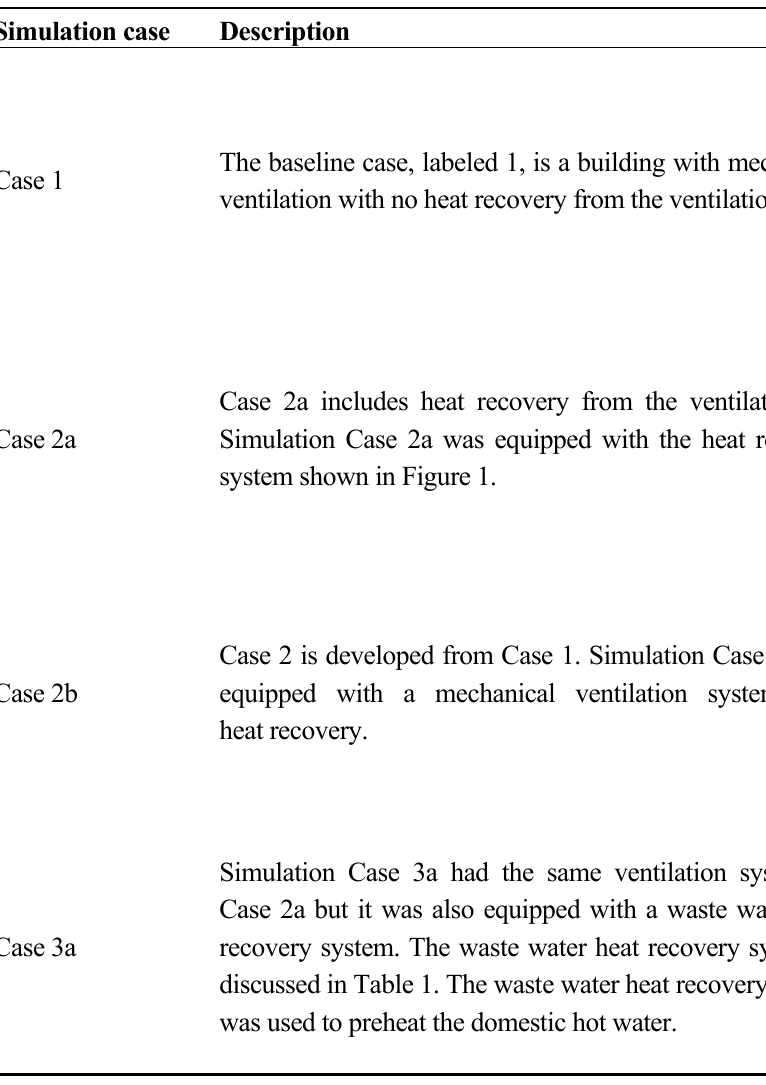
Table 2. The different investigated cases. All systems are equipped with a hot water storage tank that supplies the domestic hot